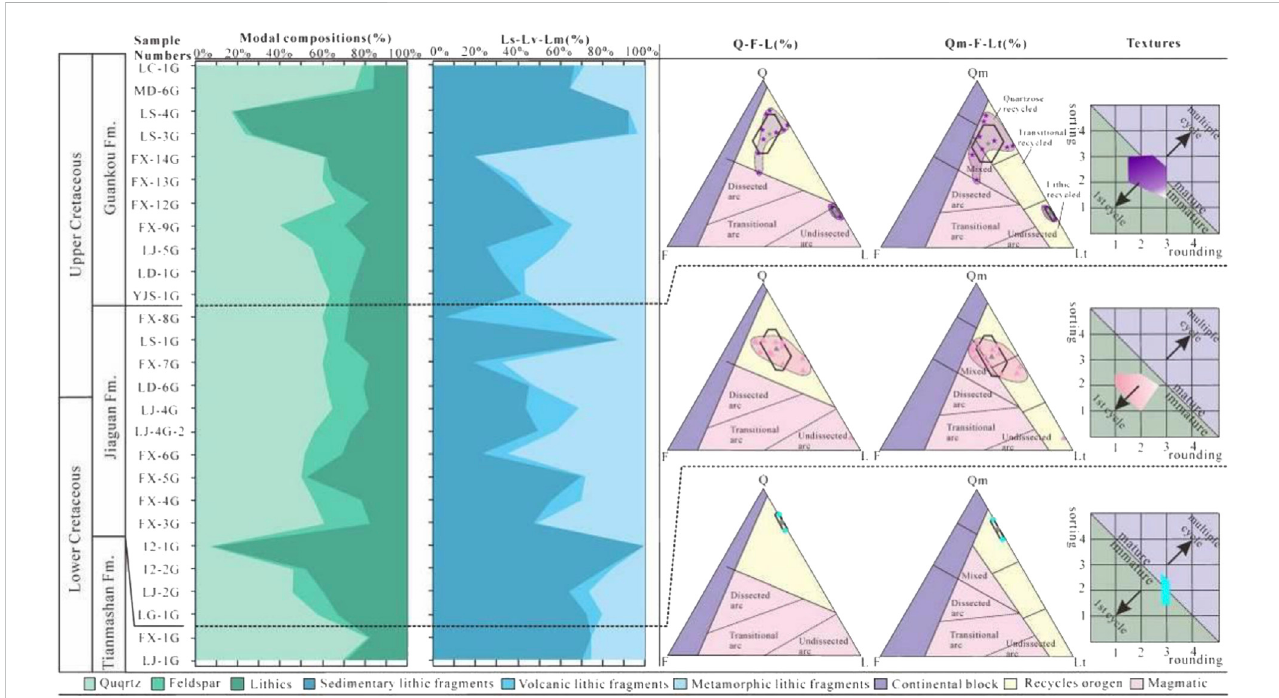
FIGURE 6 Summary of light mineral point counting of Cretaceous sandstones from the SW Sichuan basin. Ternary plots after Dickinson et al. (1983) showing possible provenance af fi liation (Q – Quartz, F — Feldspar, L – Lithic fragments, Qm – Monocrystalline quartz, Lt – Total lithic fragments). Textures after Zimmermann and Hall (2016, 2019) showing assessments of sorting and rounding using simple number schemes which were used to estimate